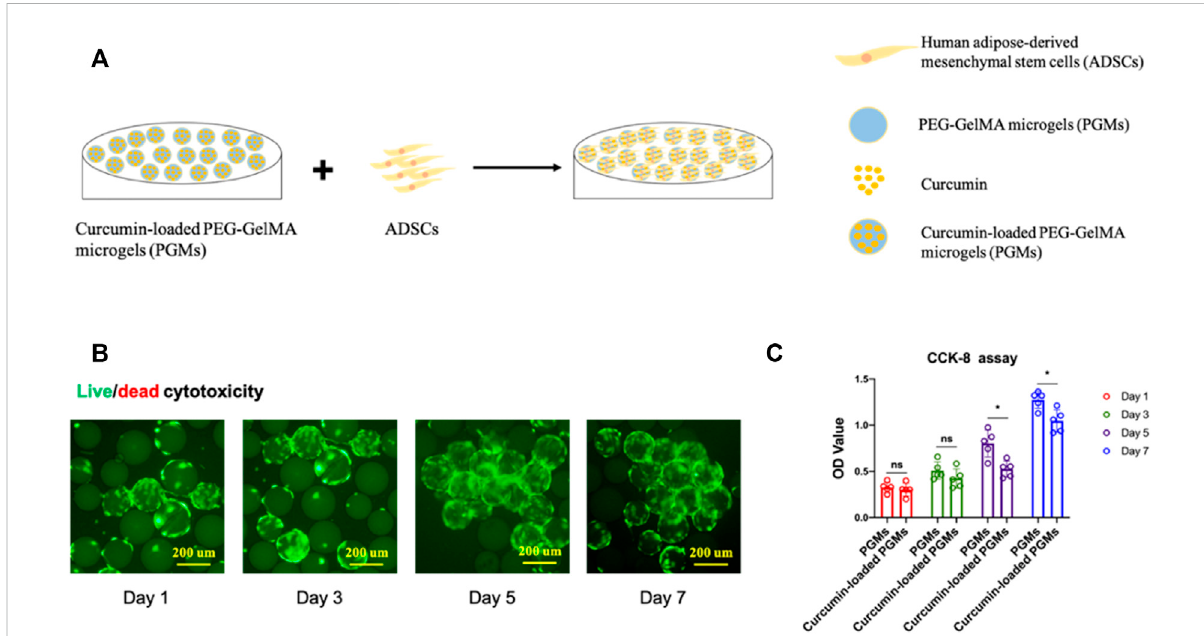
FIGURE 2 Cyto-biocompatibility and cell viability of curcumin-loaded PEG-GelMA microgel (PGMs). (A) Schematic of ADSCs seeding on the curcumin- loaded PEG-GelMA microgel (PGMs) for in vitro culture. (B) The Live/dead staining of ADSCs cultured on the curcumin (5 uM)-loaded PGMs,